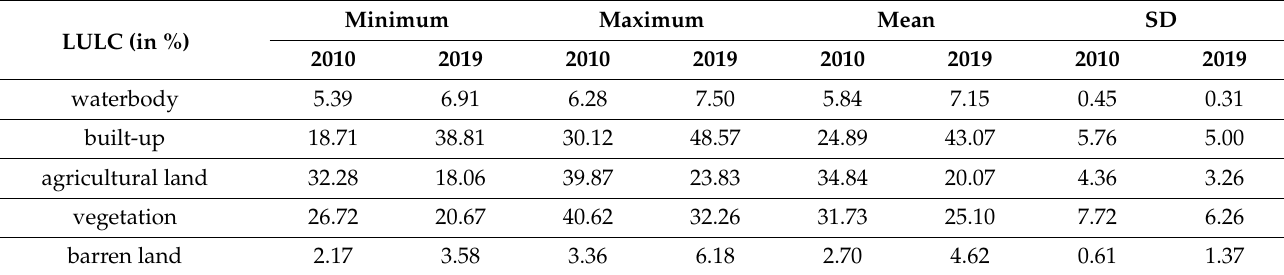
Table 6. Descriptive statistics of the LULC